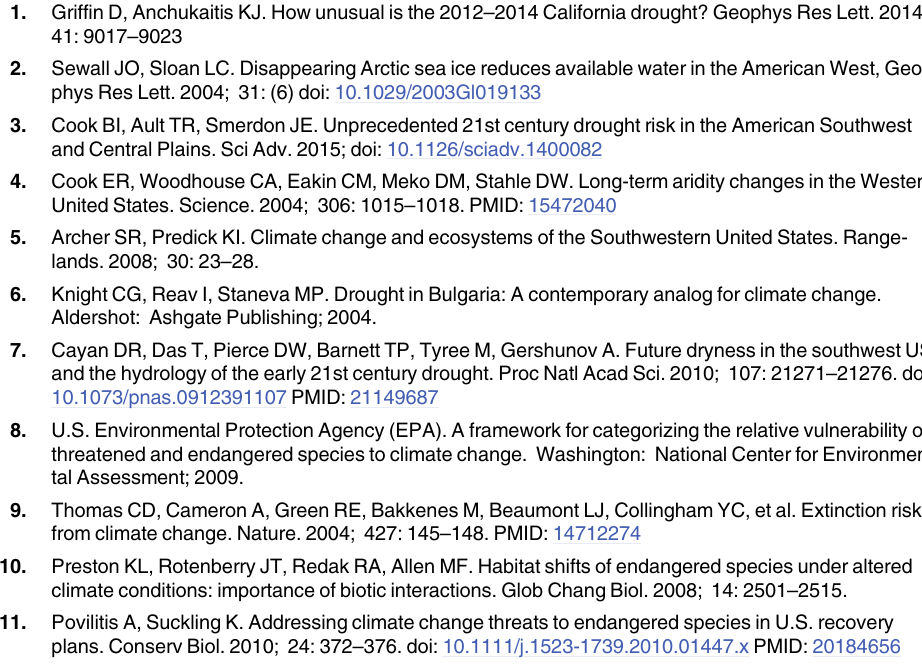
S1 Table. Table of surveyed localities and winter precipitation. Binary data in column titled “ Neonates observed in 2014 ” indicates neonates observed (= 1) or not observed (= 0). “ ns ” indicates we found no record of surveys conducted for neonates in past 3 years. S2 Table. Table of data used in model selection